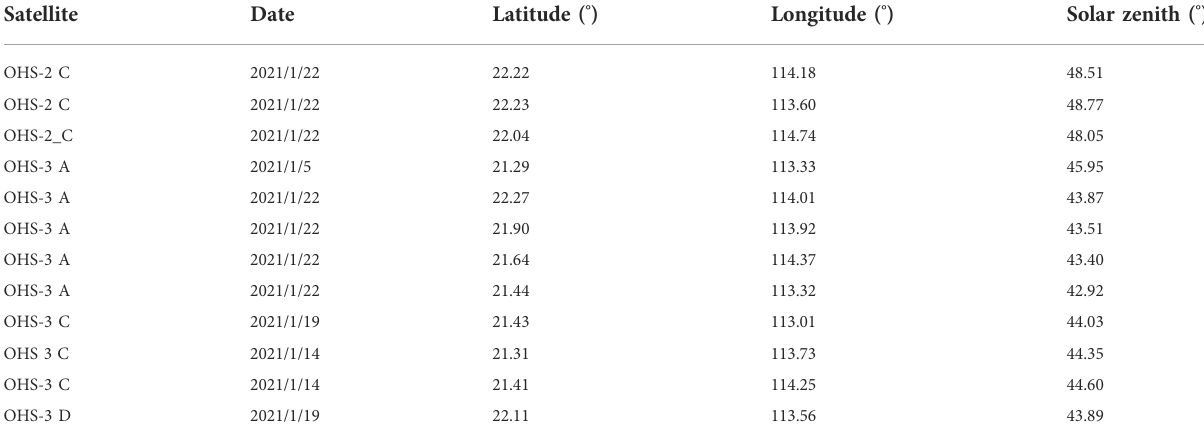
TABLE 2 OHS candidate image information.